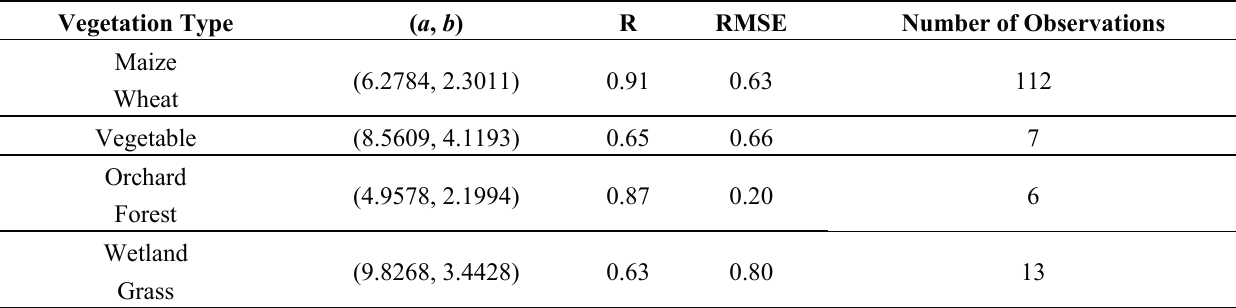
Table 5. The empirical constants in the NDVI and LAI relations (Equation (7)) for different vegetation types used in this